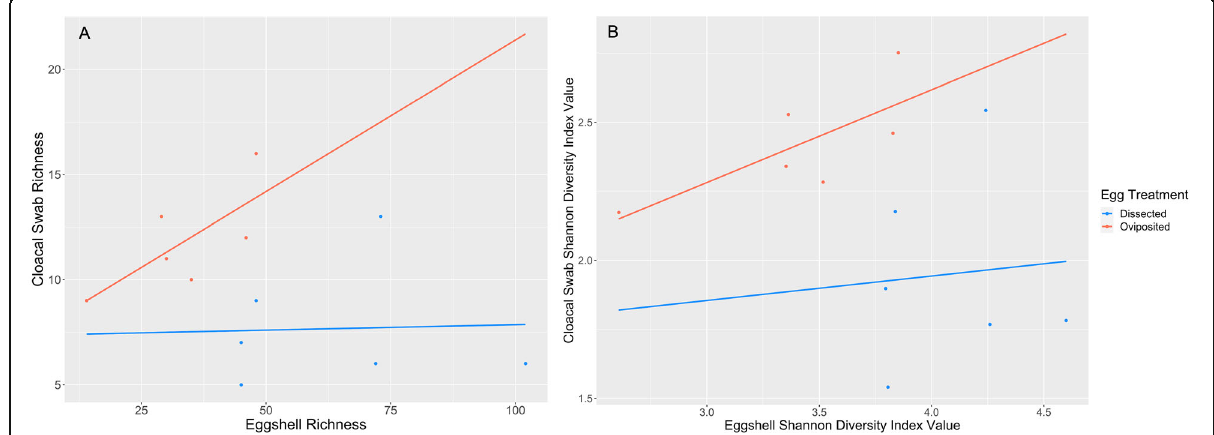
Fig. 6 Correlation of A ) observed richness and B ) Shannon diversity index of S. virgatus eggshell bacteria relative to that of the mother ’ s cloaca sampled on the same day. Correlations are not significant for dissected eggs ( p =0.940, p =0.877) but are nearly so for oviposited eggs ( p =0.102, p